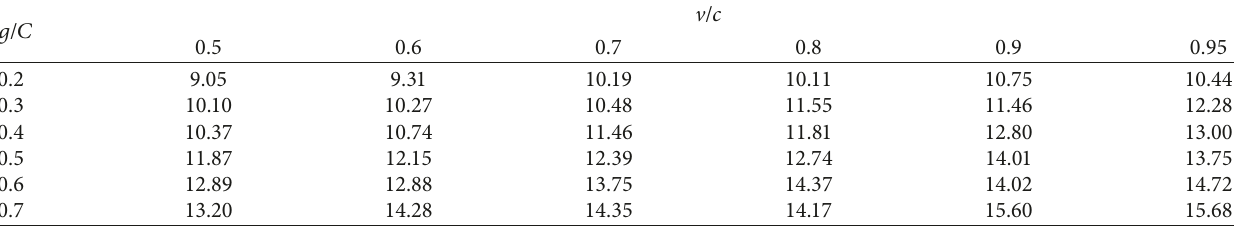
Table 9: Standard deviation of delay for different λ , x combinations.